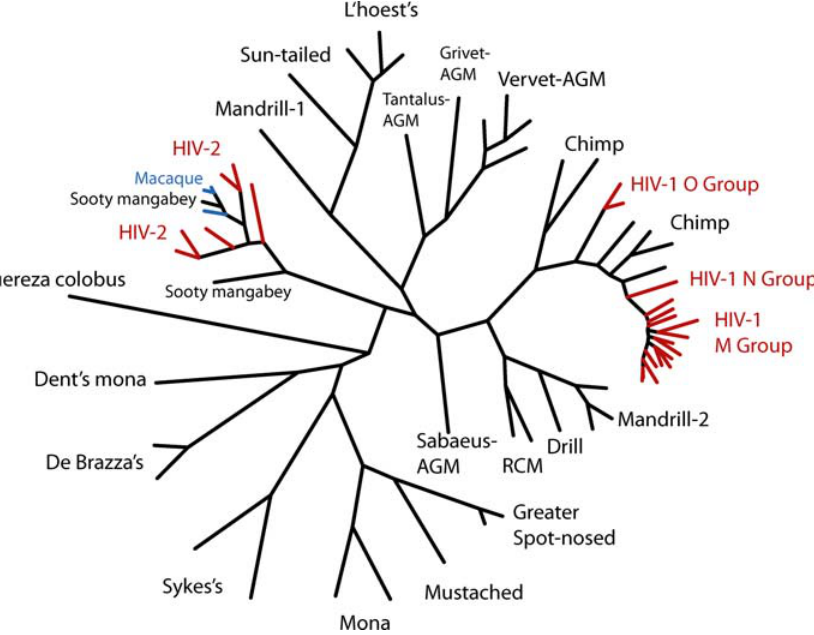
Figure 1. Evolutionary Relationships of Primate Lentiviruses Based on Maximum-Likelihood Phylogenetic Analysis of Full-Length Pol Protein Sequences Viruses responsible for natural infections of African primates are denoted by the name of the host species in black. Recent cross-species transmissions are shown in color: multiple transmissions from chimpanzees and sooty mangabeys have given rise to HIV infections in humans (red), and multiple transmissions from sooty mangabeys have given rise to nonnatural pathogenic SIV infections in rhesus, pig-tailed, and stumped-tailed macaques of Asian origin (blue). Aligned complete Pol sequences were downloaded from the Los Alamos database, and the phylogeny was generated with the PHYLIP package [23]. AGM, African green monkey; RCM, red-capped mangabey